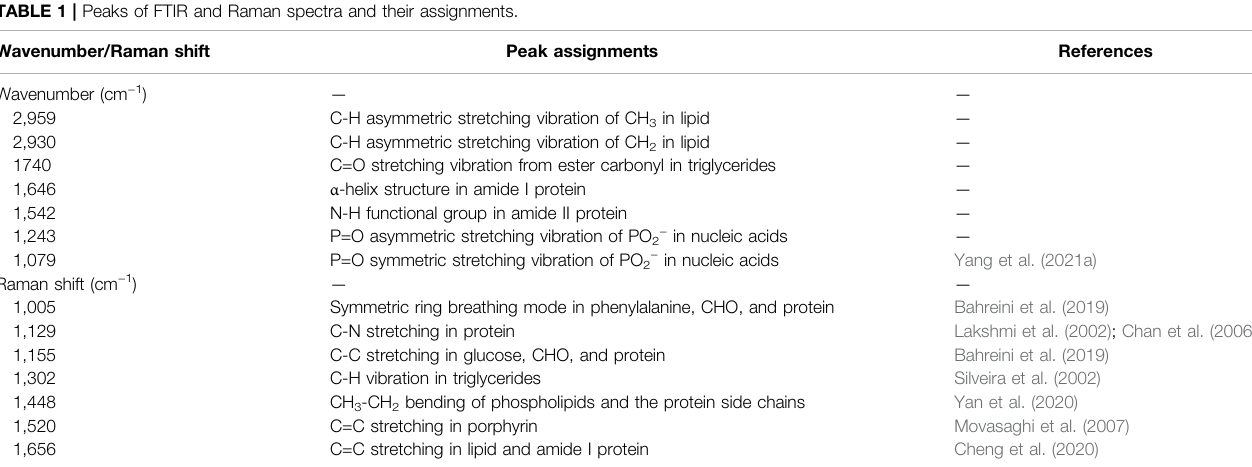
TABLE 1 | Peaks of FTIR and Raman spectra and their